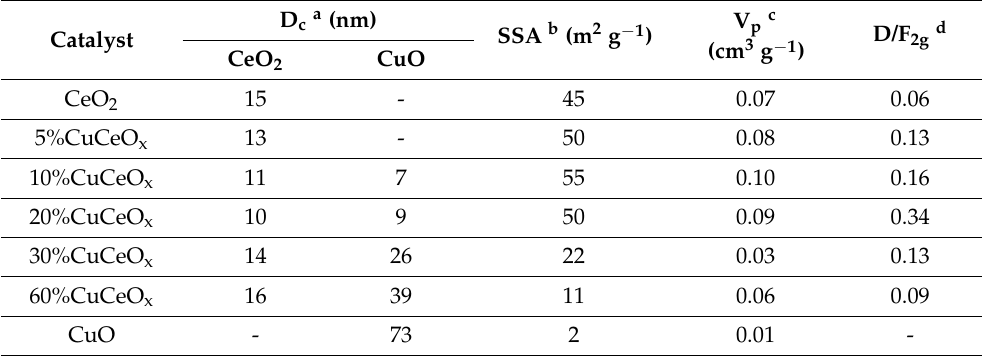
Table 1. Textural properties of the CuCeO x catalysts derived by means of X-ray diffraction, N 2 physisorption and Raman